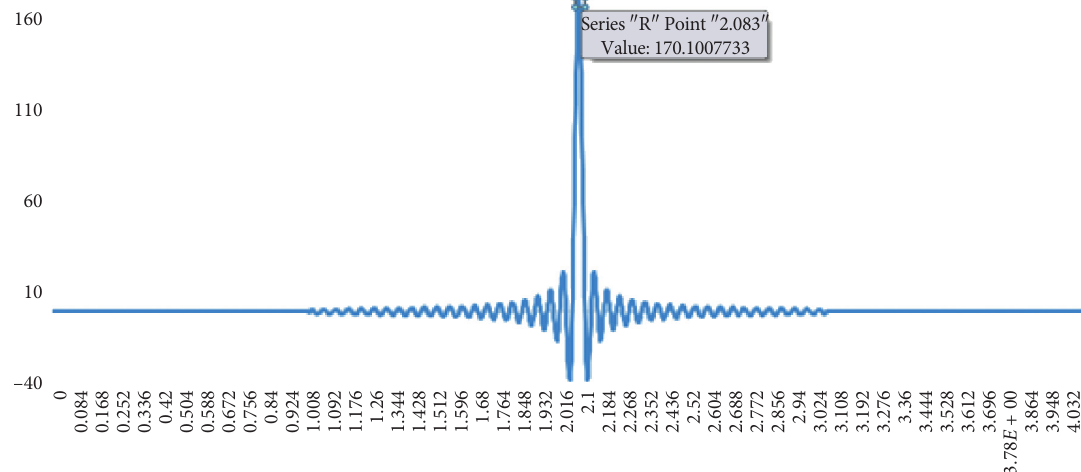
Figure 5: Illustration of the cross-correlation